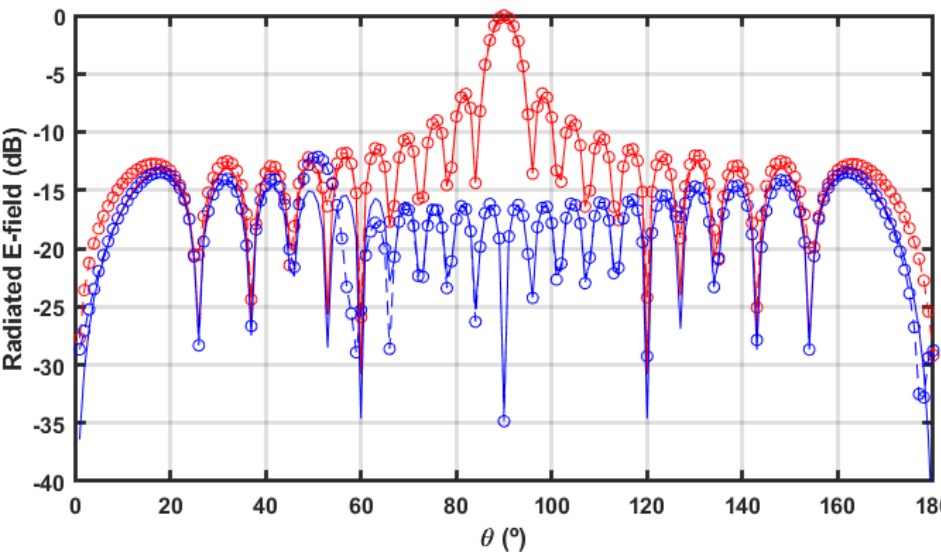
Figure 20. Radiated E-field. Case Table 2-(2) with 20 antennas step = 0.11 m: (---) Horizontal polarization (E φ ). (-o-) Horizontal polarization (E φ ) with helix. (---) E θ without helix. (-o-) E θ with helix.